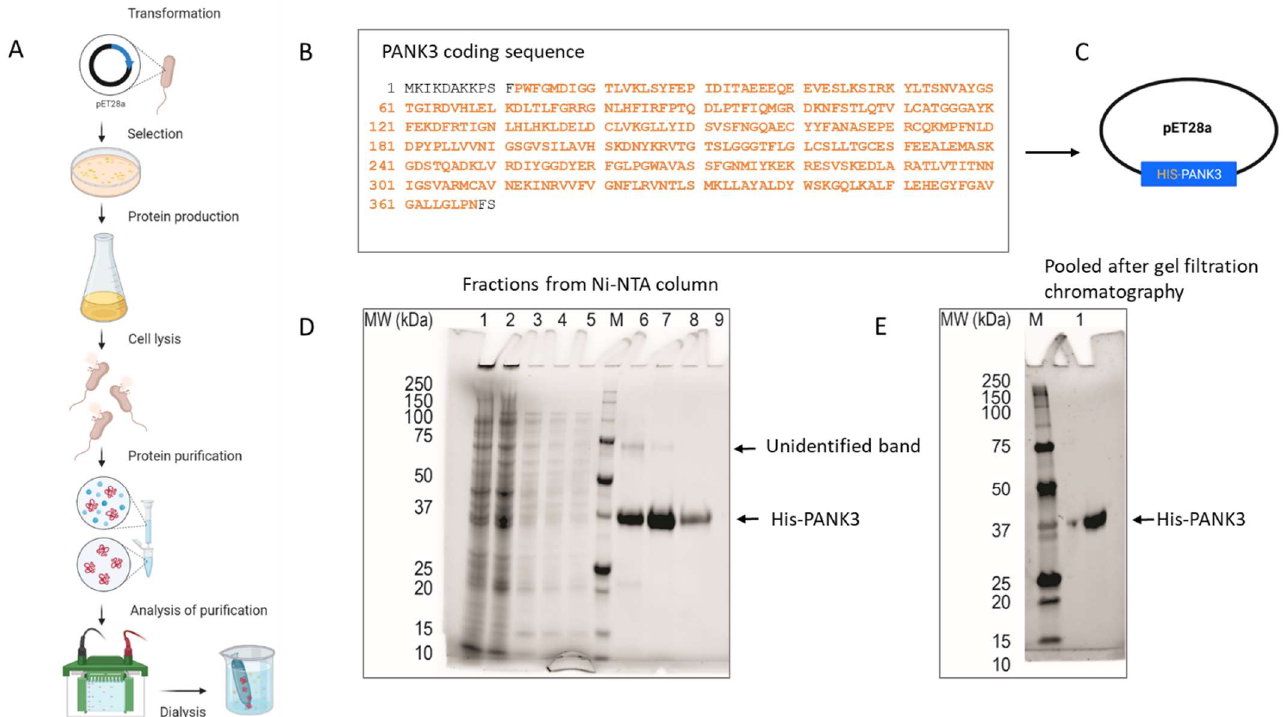
Figure 2. Generation and purification of recombinant PANK3 protein. ( A – C ) Schematic showing the recombinant PANK3 production and purification. E. coli BL21 (DE3) and E. coli Rosetta2 (DE3) strains were transformed with pET28a plasmid vector encoding N-terminal His-tagged fusion PANK3 protein (residues pro12 to Asn368—highlighted in orange). The E. coli cells were grown in Terrific Broth medium at 37 °C overnight and then the temperature of the culture was reduced to 18 °C prior to induction of the recombinant protein expression by the addition of 1 mM IPTG. Cells were harvested and lysed, and the soluble supernatant was applied in a pre-equilibrated Ni-NTA column, to allow the histidine tag to bind to the column. After washing the column, the bound proteins were eluted in 10 different fractions. ( D , E ) SDS PAGE gel was stained with Coomassie Blue to assess the presence of His-PANK3 in the fractions. PANK3 protein purified from the Ni-NTA column was further subjected to gel filtration chromatography. Purified PANK3 protein eluted through gel filtration was validated by SDS-PAGE gel and Coomassie staining.